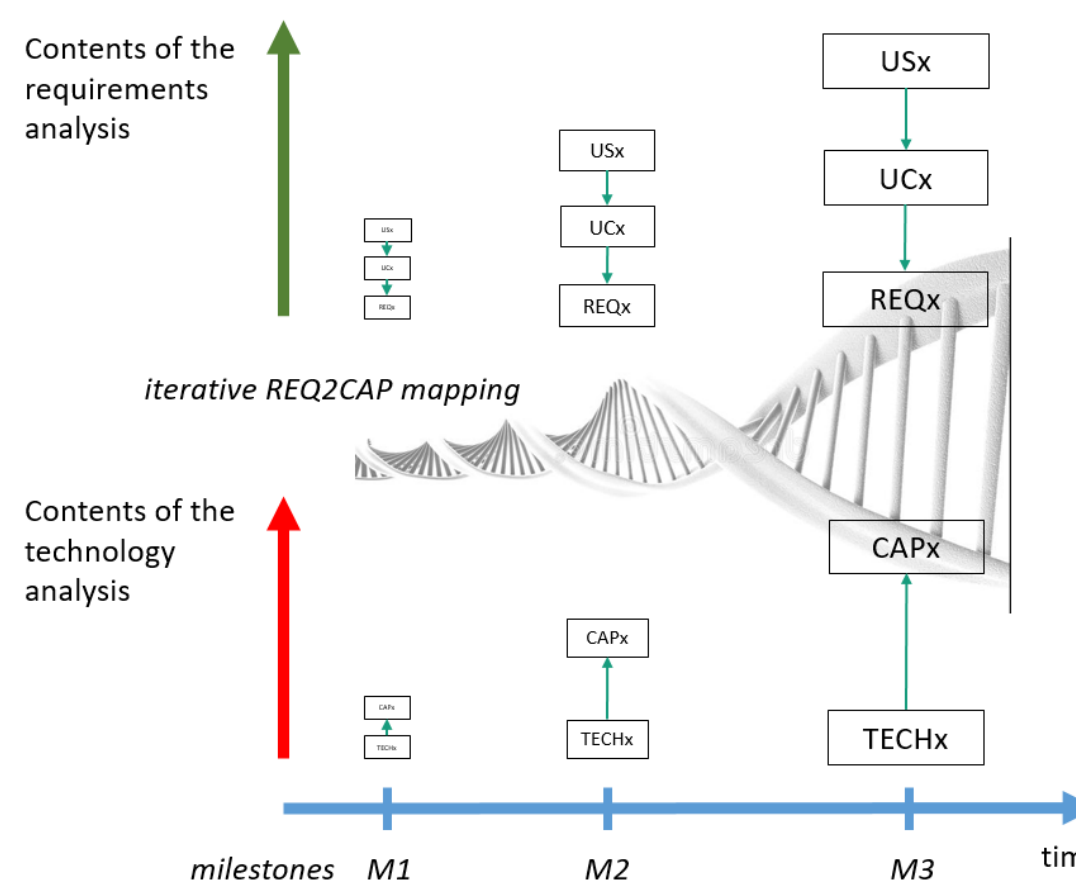
Figure 10. Agile content generation for the PEIS and iterative REQ2CAP mapping.